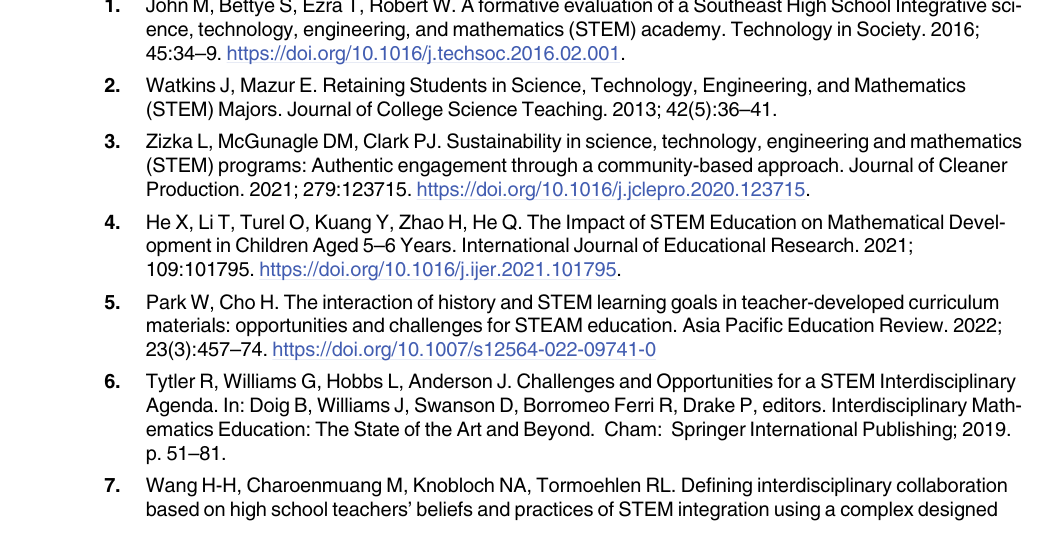
S2 Table. Raw database. S3 Table. Results of the MICOM